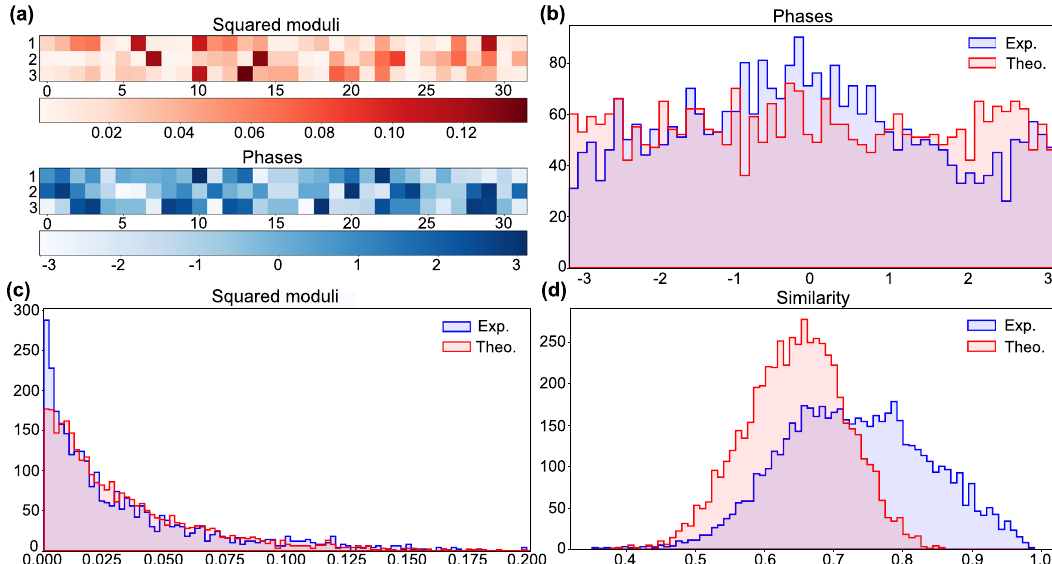
Fig. 3 Experimental reconstruction of the [3 × 32] sub-matrices and comparison with the Haar-random matrices. a Experimental reconstruction of the squared moduli ρ 2 (red) and phases θ ij (blue) for three input ports of the recon fi gurable photonic chip, highlighted by ij the labels in the fi gure. The chip is set on a random con fi guration of currents. Each input port represents a row of the unitary transformation applied to the input state. b , c Comparison of the phases and the squared moduli frequency distribution respectively, between 15 experimentally reconstructed sub-matrices (blue) and 15 [3 × 32] sub-matrices sampled from the Haar-random unitaries (red). d Distribution of the similarity between the squared moduli of two columns of different sub-matrices. We repeated the measurement for ~200 different con fi gurations of the currents in the chip. In red it is shown the theoretical similarity distribution obtained by sampling columns distributed according to the Haar measure. The overlap between the two histograms is the 62.4% of the total